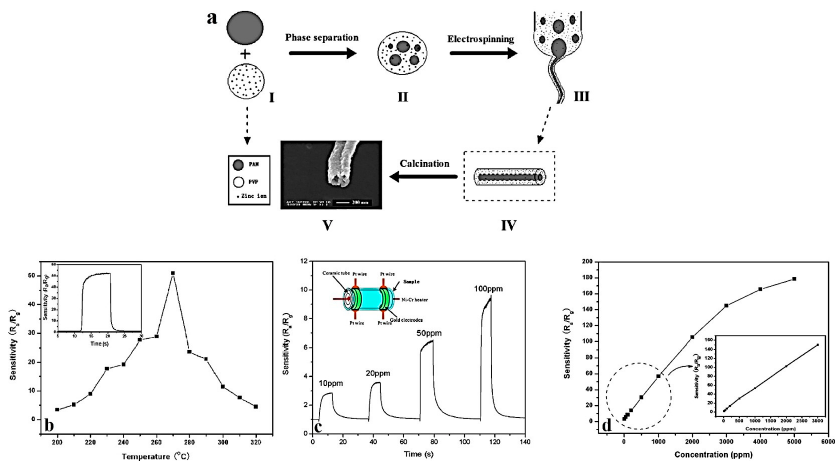
Figure 10. ( a ) The schematic demonstration of various steps of the formation process of ZnO hollow nanofibers; ( b ) ethanol sensitivity of the ZnO hollow nanofibers at different operating temperatures (the inset shows the response–recovery curve of the nanofibers exposed to 1000 ppm of ethanol); ( c ) dynamic response of the sensor to ethanol, whose concentration varies from 10 to 100 ppm (the inset image shows, schematically, the ZnO hollow nanofibers sensor connected to the electrodes); ( d ) the sensor sensitivity versus ethanol concentration (the inset graph implies a linear relationship between sensitivity and ethanol concentration) (Reproduced with permission from [20]. American Chemical Society, 2017).